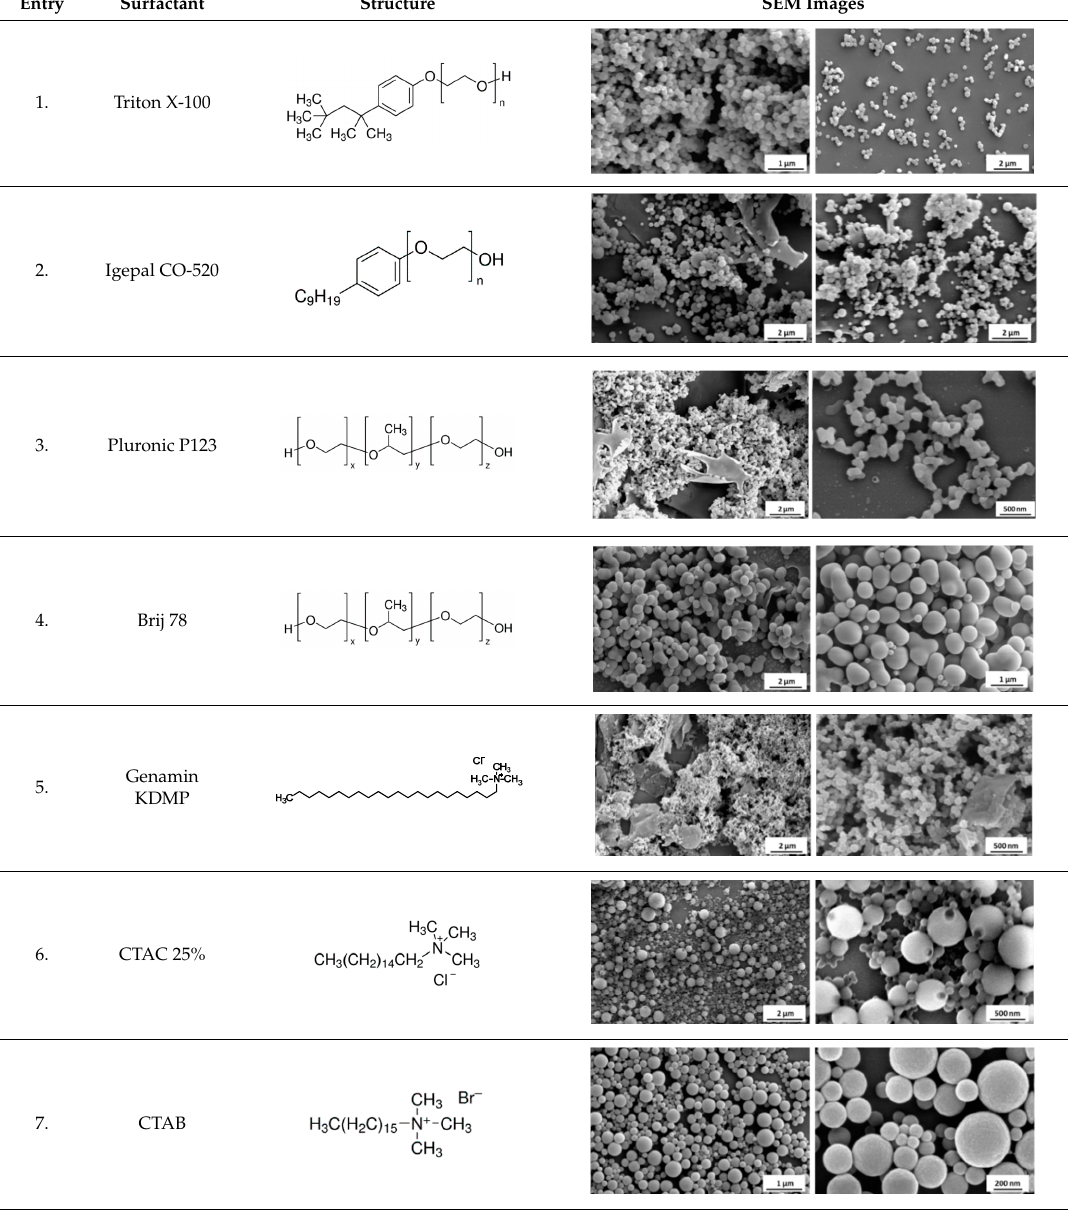
Table 1. Preparation of a chiral PMO system from 1,1 (cid:48) -(( 1R,2R )-1,2-diphenylethane-1,2-diyl)bis(3- (3-(triethoxysilyl)propyl)urea) ligand ( 4 ) with di ff erent surfactants.